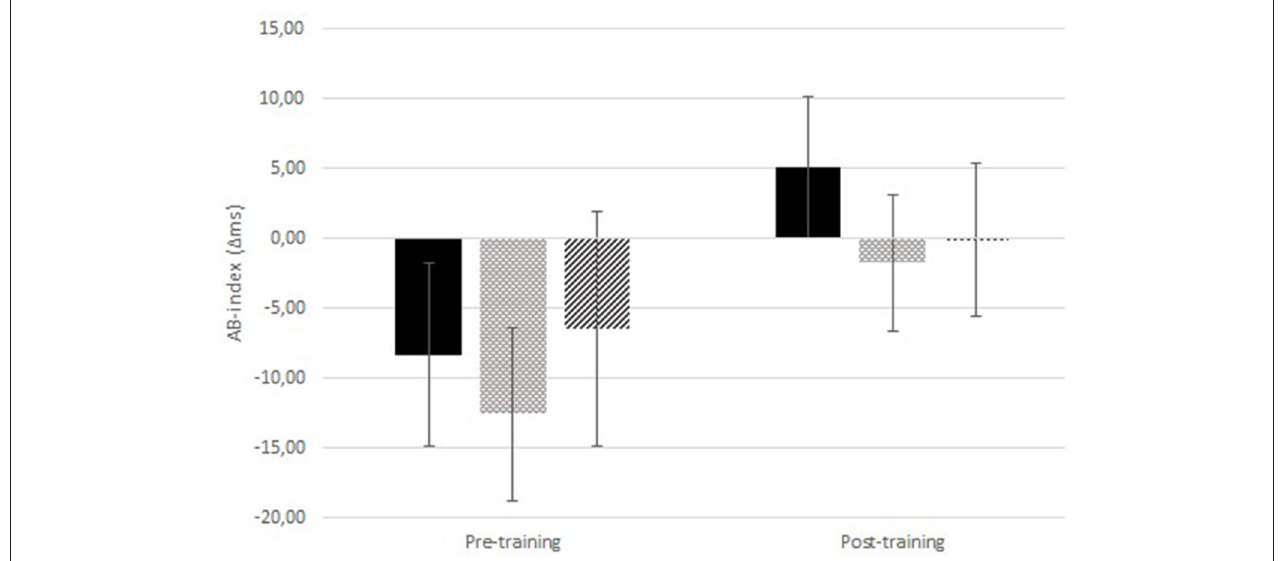
FIGURE 2 | Attentional Bias (AB)-index for the itch pictures pre- and post-ABM-training. Results are displayed for the ABM-training away from itch (black; n = 38), ABM-training toward itch (light gray dots; n = 40), and the sham training (intermediate gray stripes; n = 37). Positive values indicate an AB toward itch. Error bars represent standard errors of the mean.